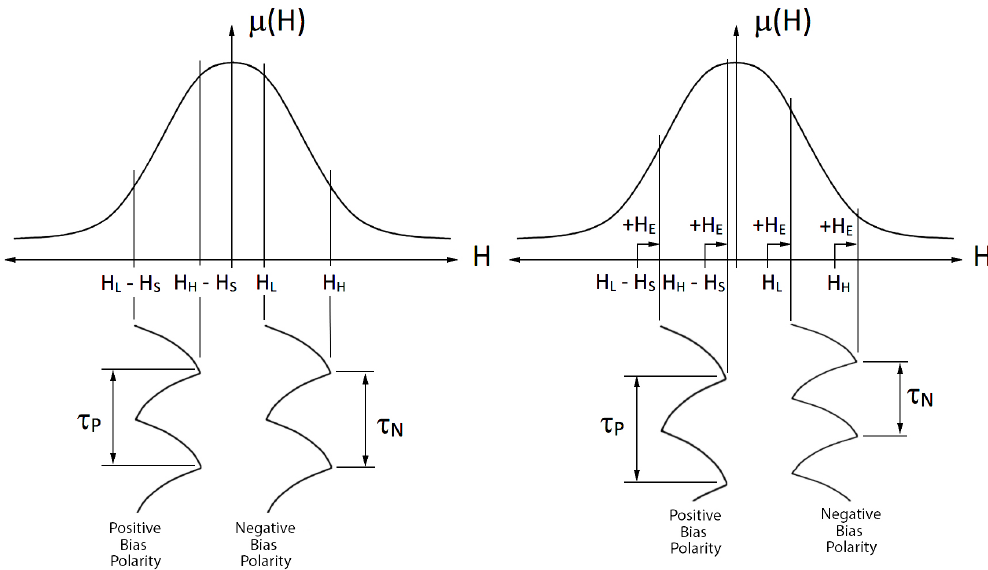
Figure 3. The induction in the coils as a function of applied magnetic field (top) and the traces of the oscillating current in the solenoid and the period for positive and negative bias polarity (bottom) (from Leuzinger and Taylor, 2010).